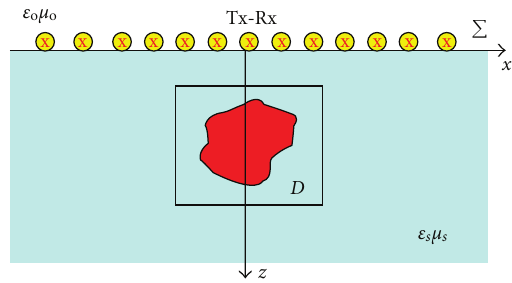
Figure 1: Geometry of the